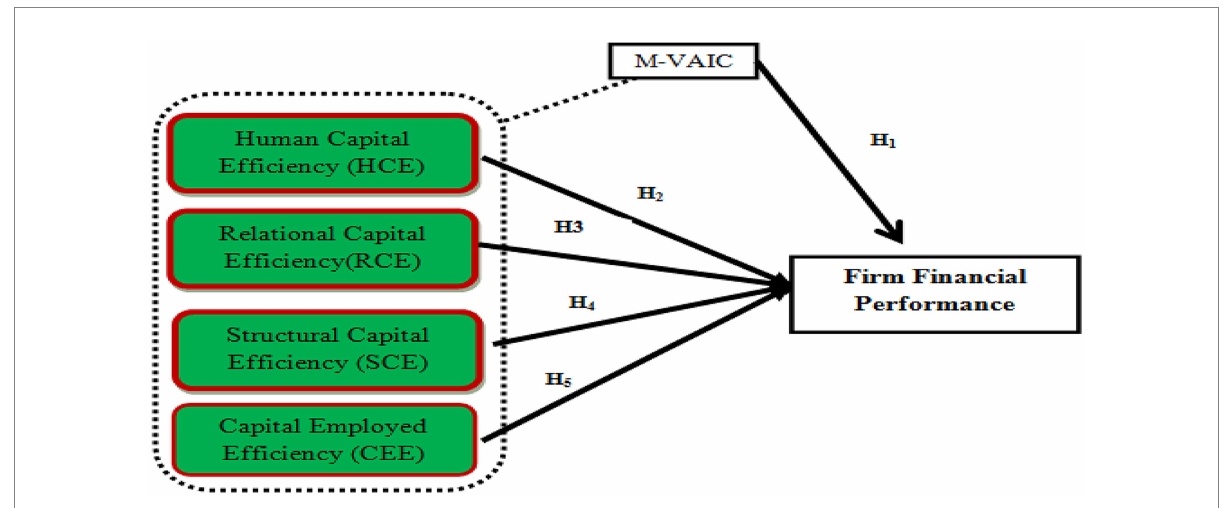
FIGURE 1 Theoretical